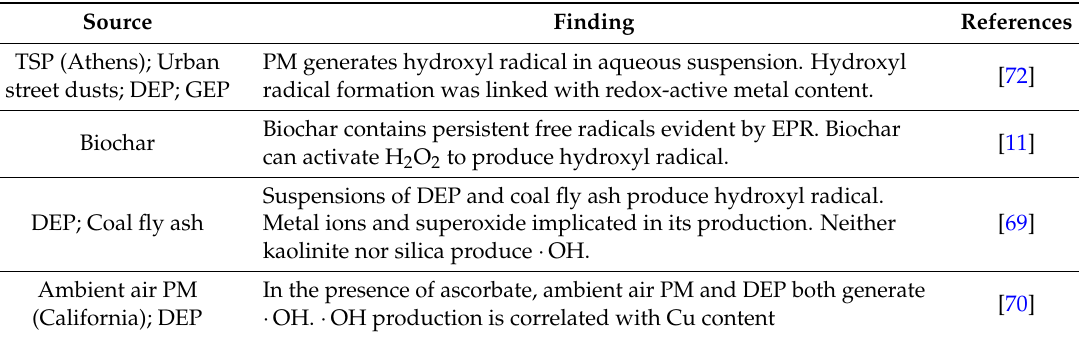
Table 2. Evidence for the ability of EPFRs to generate reactive oxygen